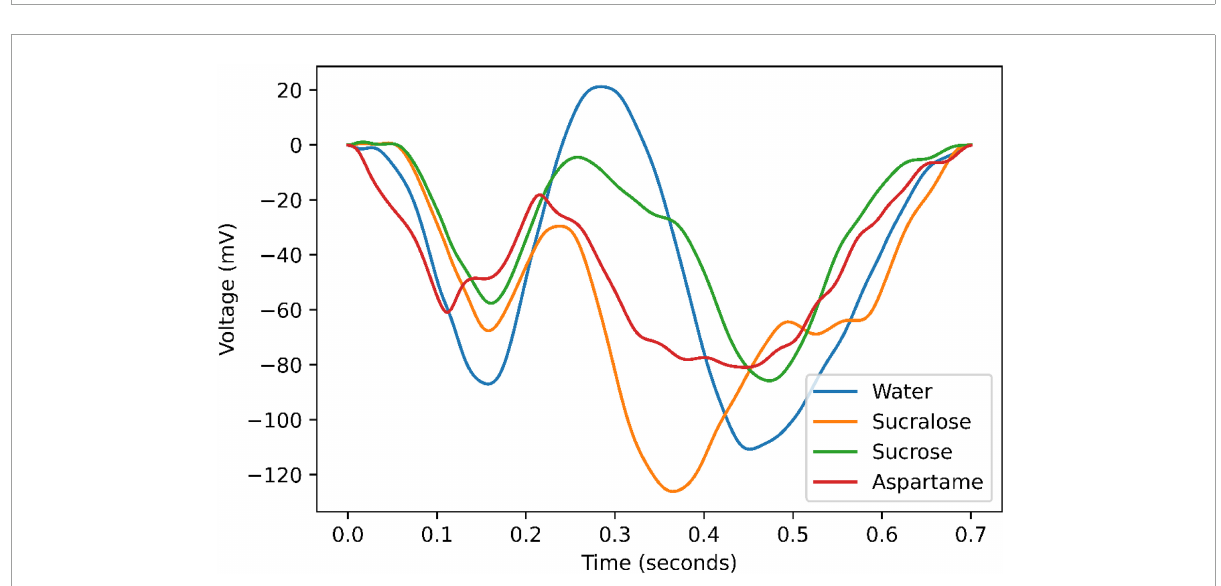
FIGURE2 Signal strength quantified as the average within-subjects over two electrodes for each of the tastants and